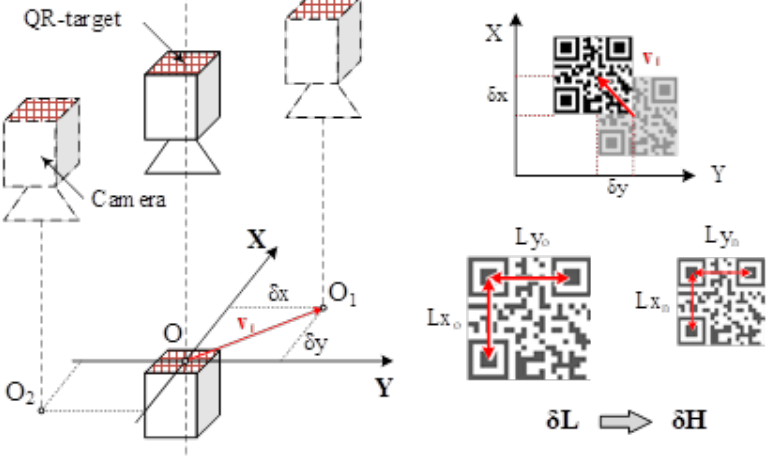
Figure 16. Displacement geometry in the horizontal plane.